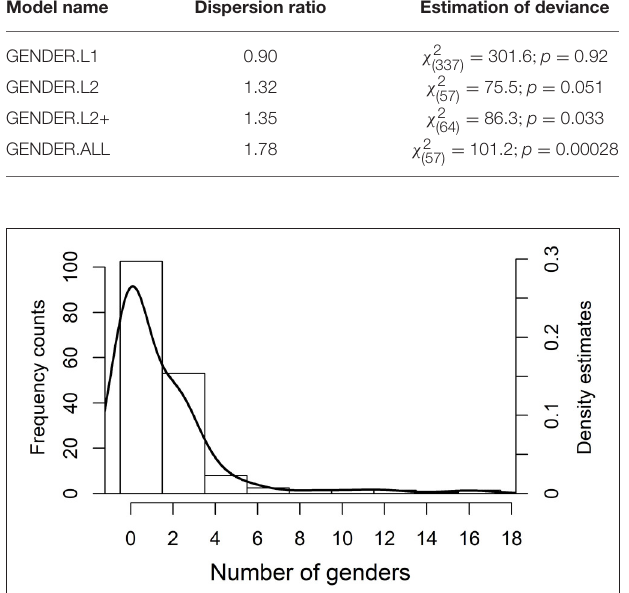
FIGURE 9 | Frequency histogram and the superimposed density estimates for the number of genders in the sample languages (because no language has exactly one gender we smoothed over this absence by using biased cross-validation for bandwidth in density